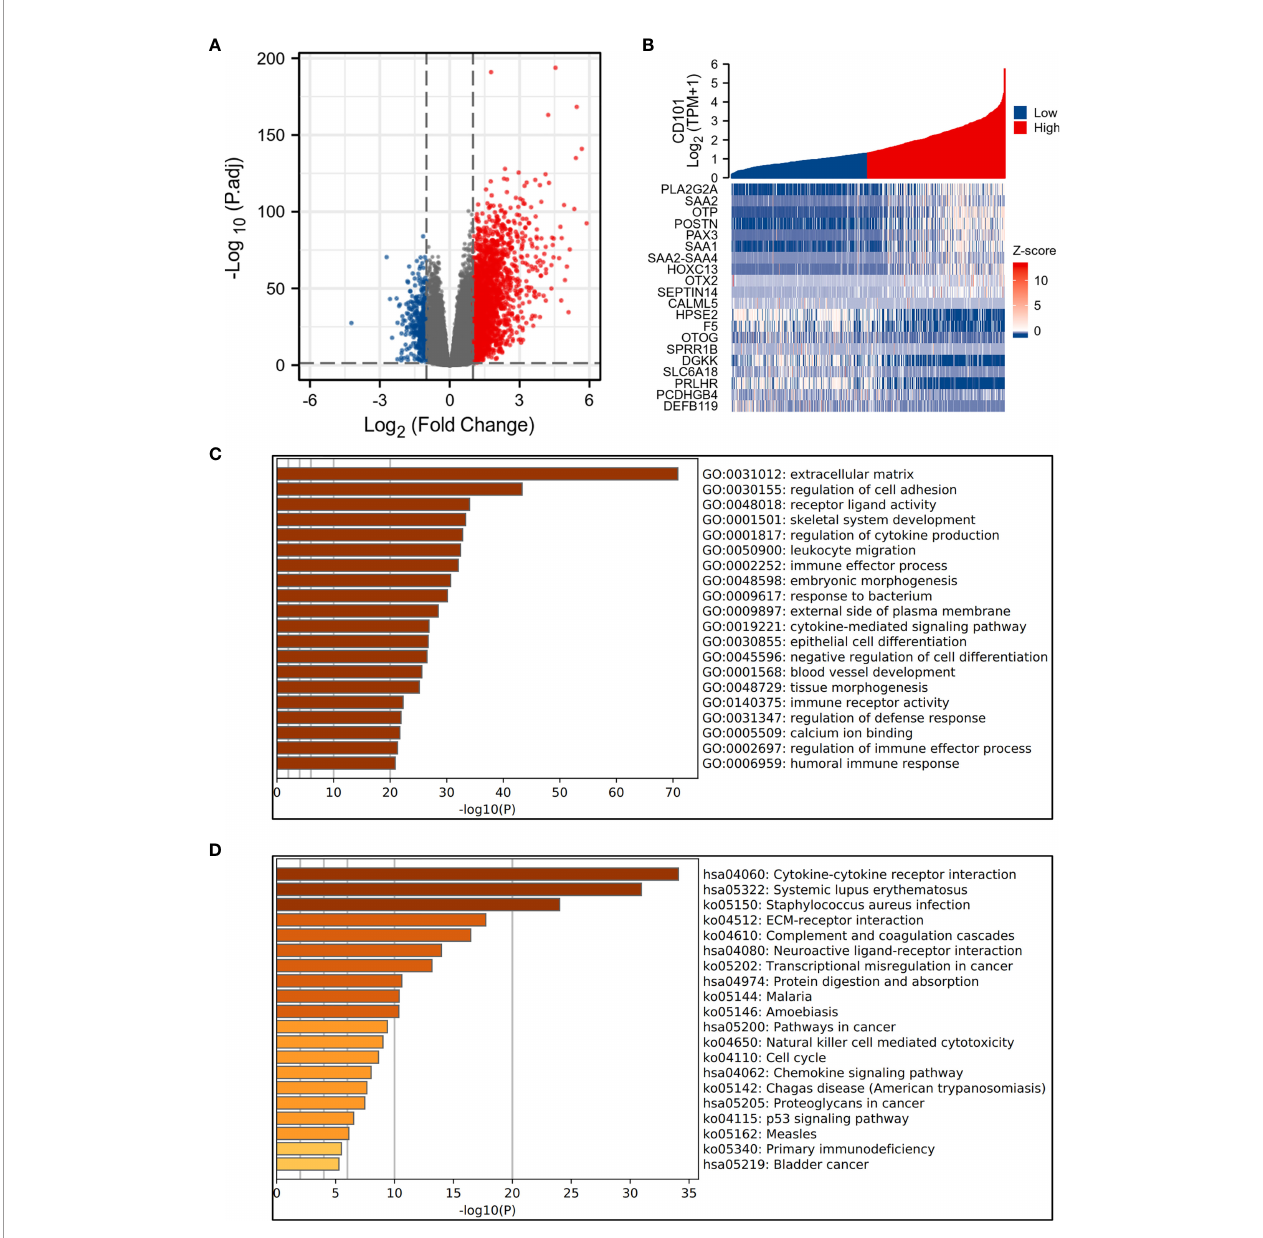
FIGURE 5 | Functional enrichment analysis of 2,469 DEGs. (A) The volcano plot of 2,469 DEGs. (B) Heat maps showing the top 10 upregulated and downregulated DEGs. (C) Top 20 terms of GO enrichment analysis. (D) Top 20 terms of KEGG enrichment